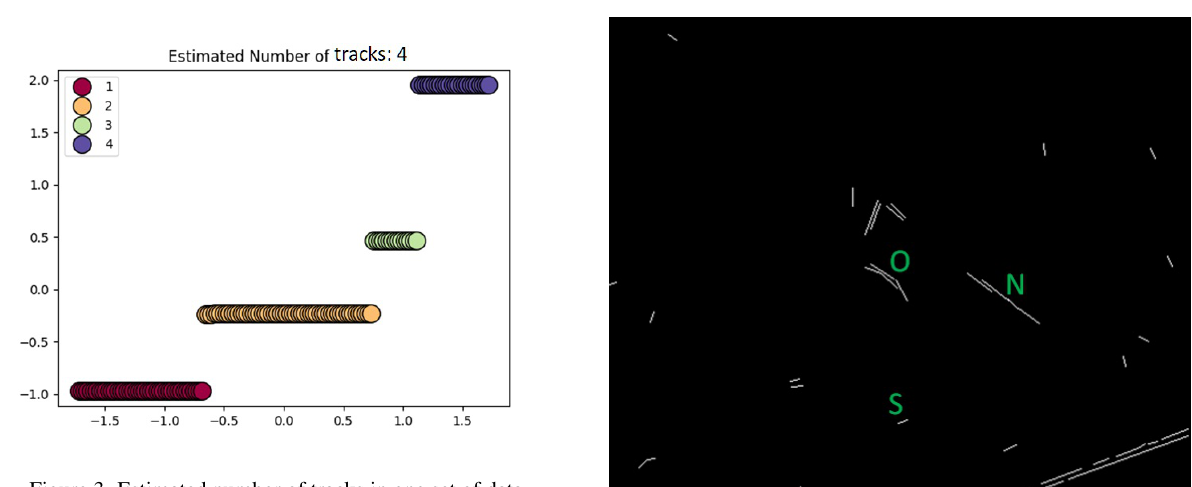
Figure 3. Estimated number of tracks in one set of data